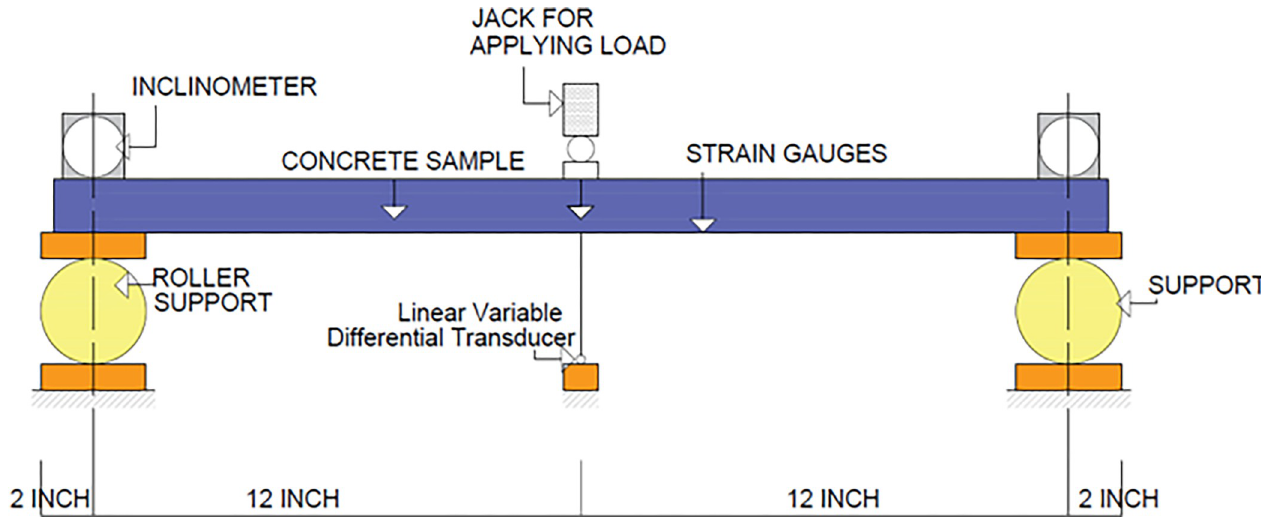
Fig 5. Test setup for flexural